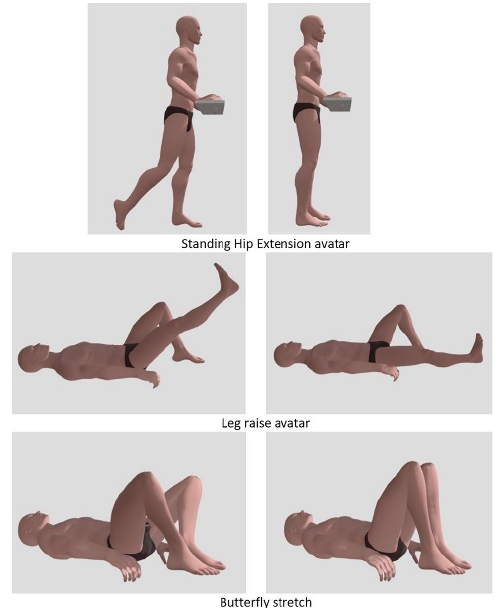
Figure 8. Example of three exercises recorded according the movements of a skilled physiotherapist and transferred to an avatar.